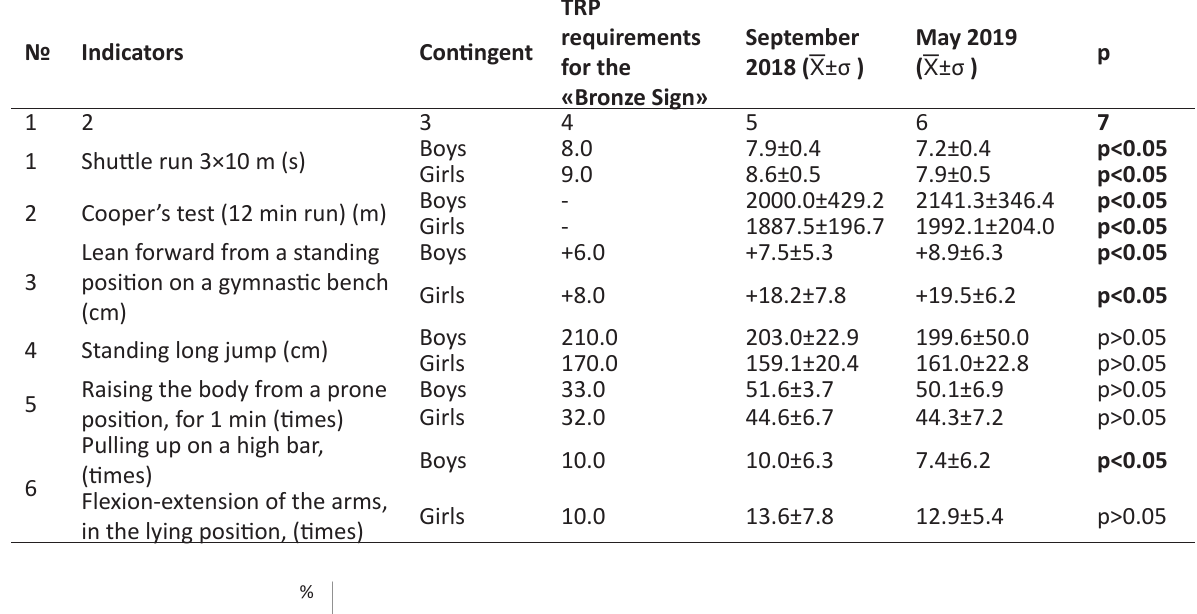
Table 4. Change of indicators of general physical fitness of students going in for sports and outdoor games